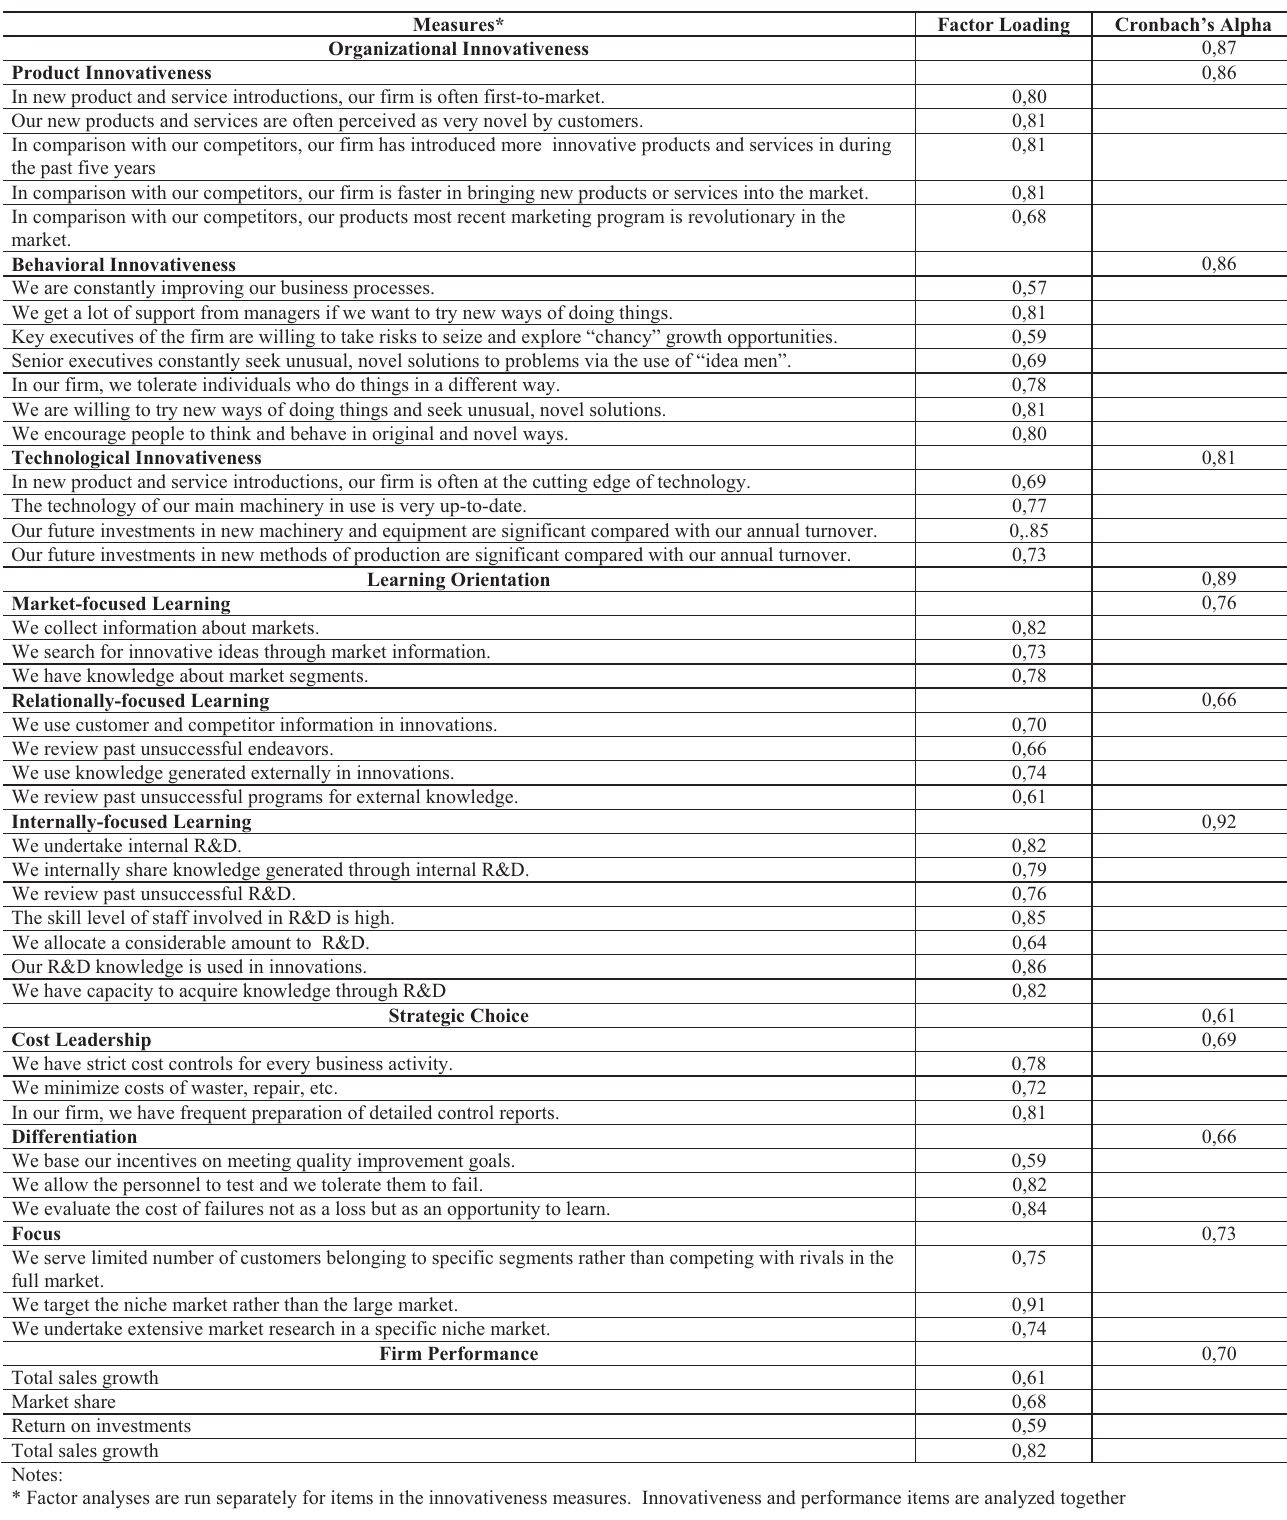
Table 1: Final measures and psychometric properties Measures* Factor